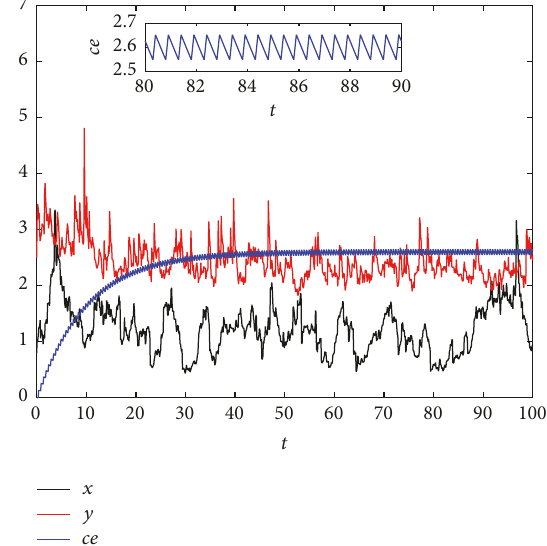
Figure 2: Sample paths of 𝑥(𝑡) and 𝑦(𝑡) with initial conditions 𝑥(0) = 0.8 and 𝑦(0) = 2.5